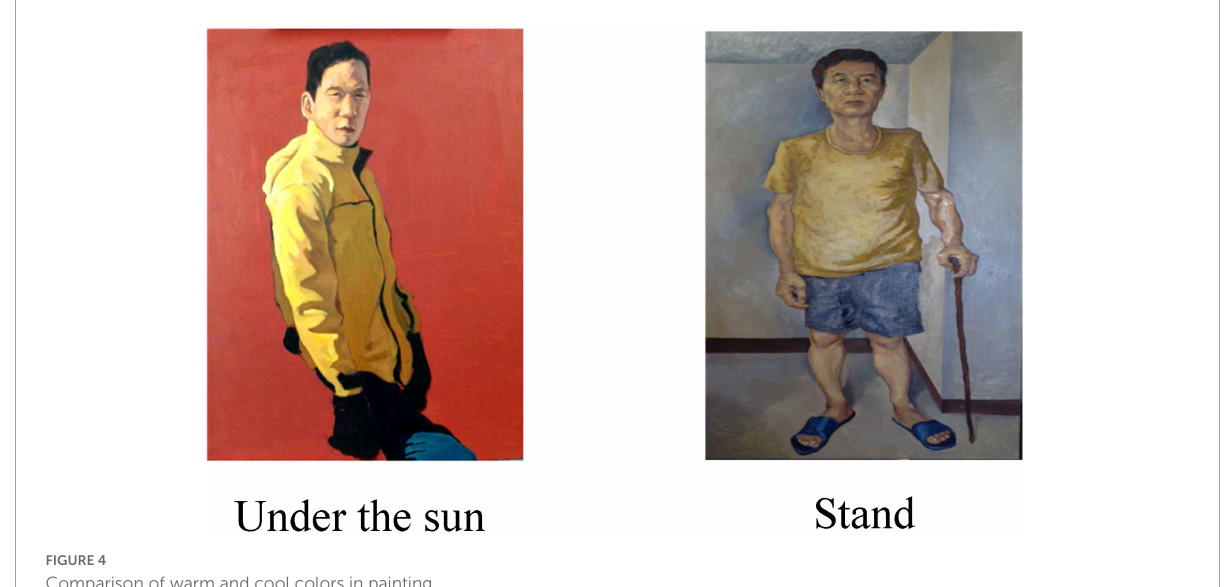
FIGURE4 Comparison of warm and cool colors in painting.